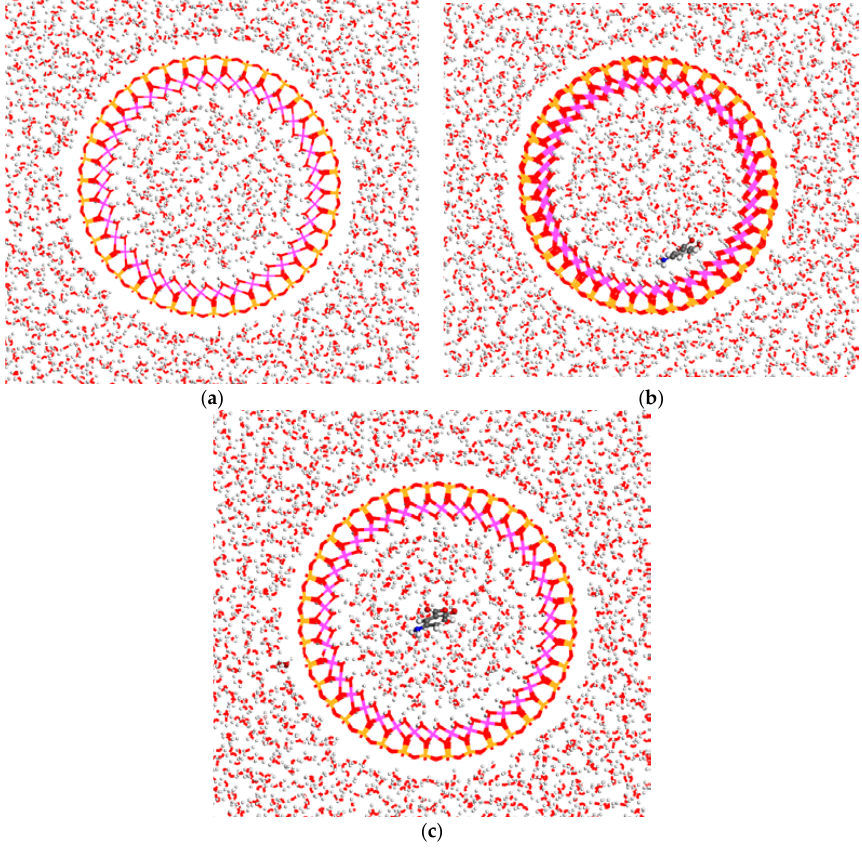
Figure 9. Optimized halloysite models filled with water, viewed from the (001) plane, before adsorption ( a ); and the adsorption complexes with 5-ASA F1Wsurf ( b ); and F1Wcenter ( c ).